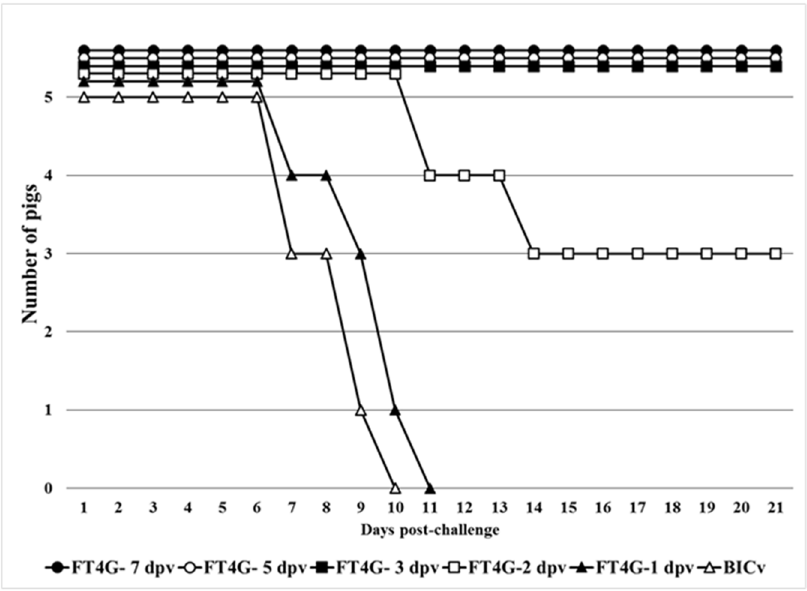
Fig 1. Mortality in FlagT4Gv-infected animals challenged at different times post-infection with virulent BICv. Groups of animals(n = 5) were IM inoculated with 10 5 TCID 50 of FlagT4Gv and IN challengedwith BICv 1, 2, 3, 5 or 7 days later. Animalswere clinicallyobservedfor 21 days post-challenge.